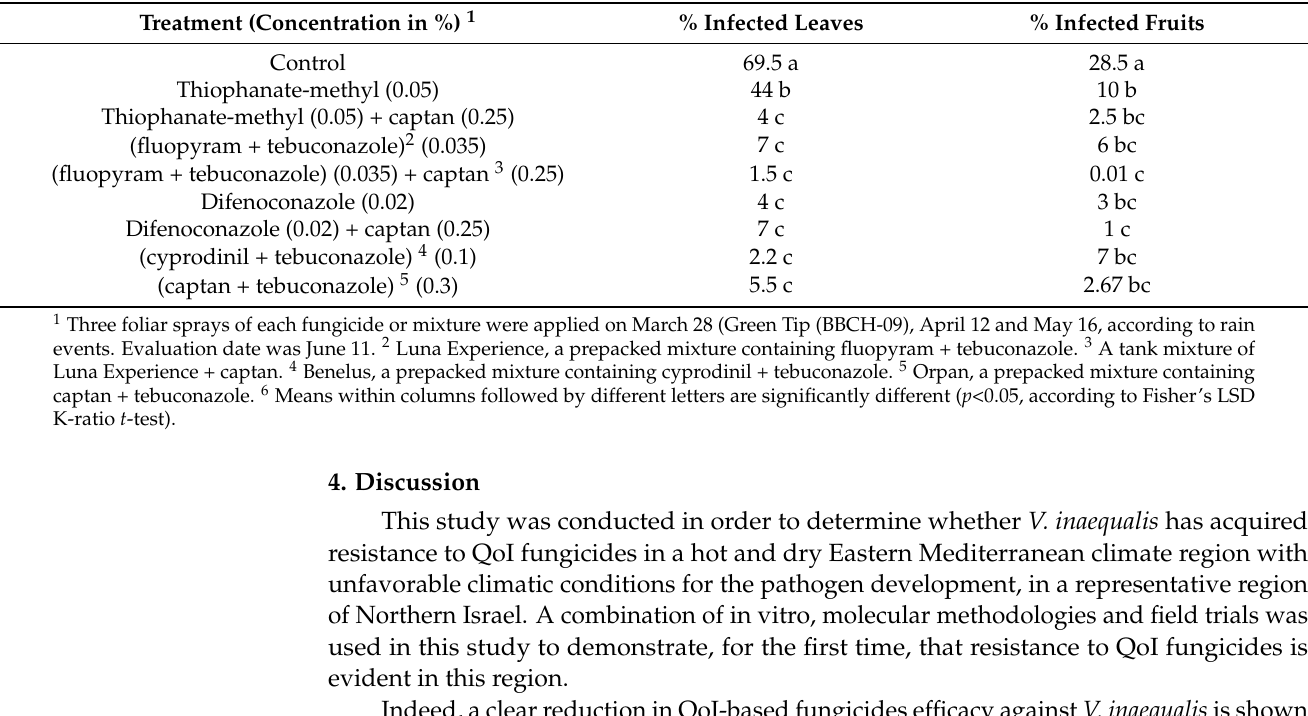
Figure 9. Efficacy of prepacked fungicidal mixtures compared to kresoxim-metyl at 0.015% (w/v) alone in controlling apple scab. Buq’ata, 2015. Prepacked mixture Discovery at 0.075% (v/v) (containing boscalid + trifloxystrobin) and prepacked mixture Orpan at 0.3% (v/v) (containing tebuconazole + captan) were used. Bars represent the standard error of the mean. Different letters on the bars indicate significant differences ( p < 0.05) according to Fisher’s LSD K-ratio t -test. Table 8. Efficacy of various fungicides and their mixtures in controlling apple scab on Starking Delicious apple leaves and fruits in the orchard,